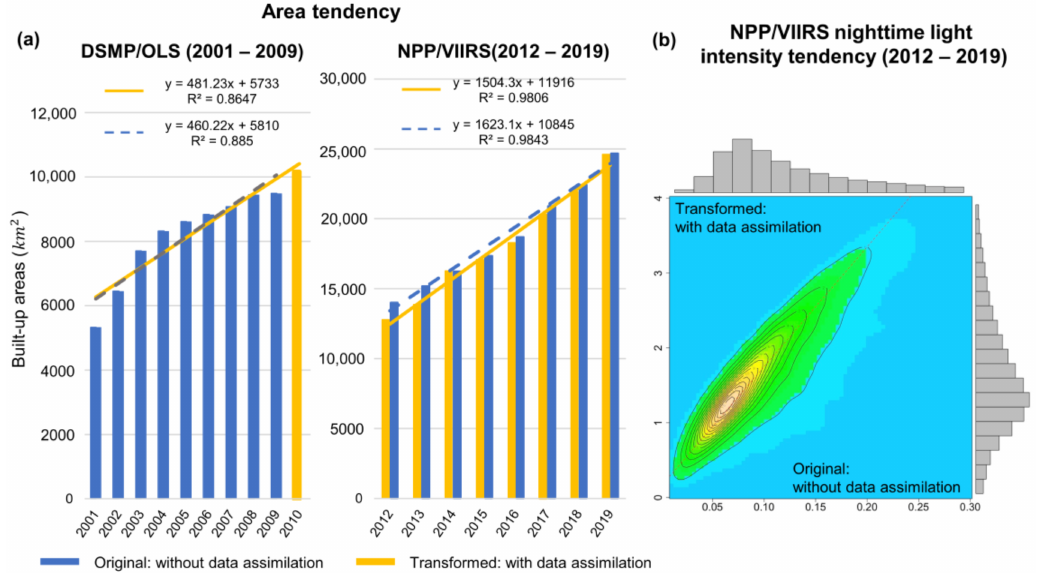
Figure 4. The original (excluding F18 and without data assimilation, in blue) versus employing data assimilation (see Section 2, in yellow): ( a ) area and ( b ) nighttime light intensity tendencies of the DMSP/OLS data in 2001–2009 versus the NPP/VIIRS data in